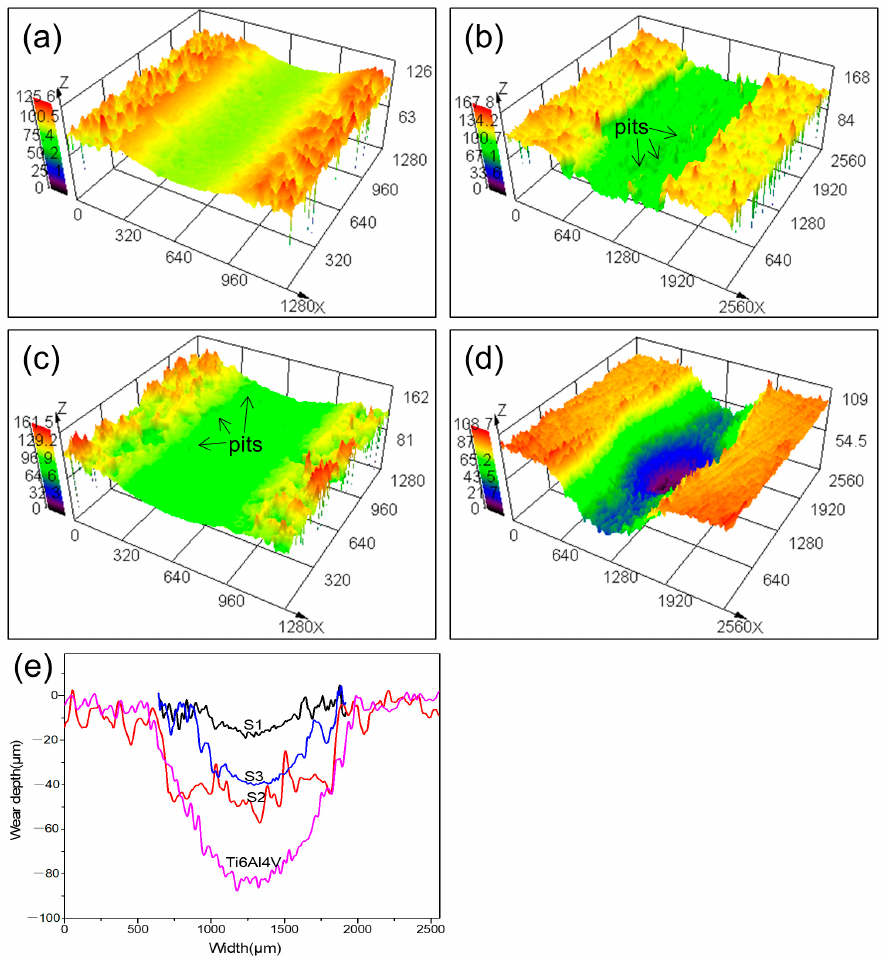
Figure 9. 3D morphology of wear tracks on different samples ( a ) S1; ( b ) S2; ( c ) S3; ( d ) Ti6Al4V substrate; ( e ) cross-sectional profiles of wear tracks.